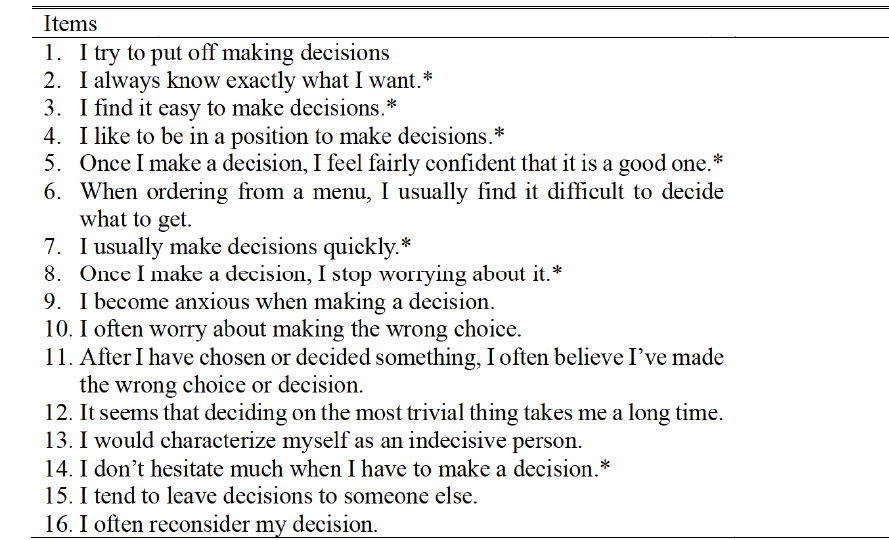
<Table 2> The Items for the Chronic Indecisiveness Index (Studies 1 and